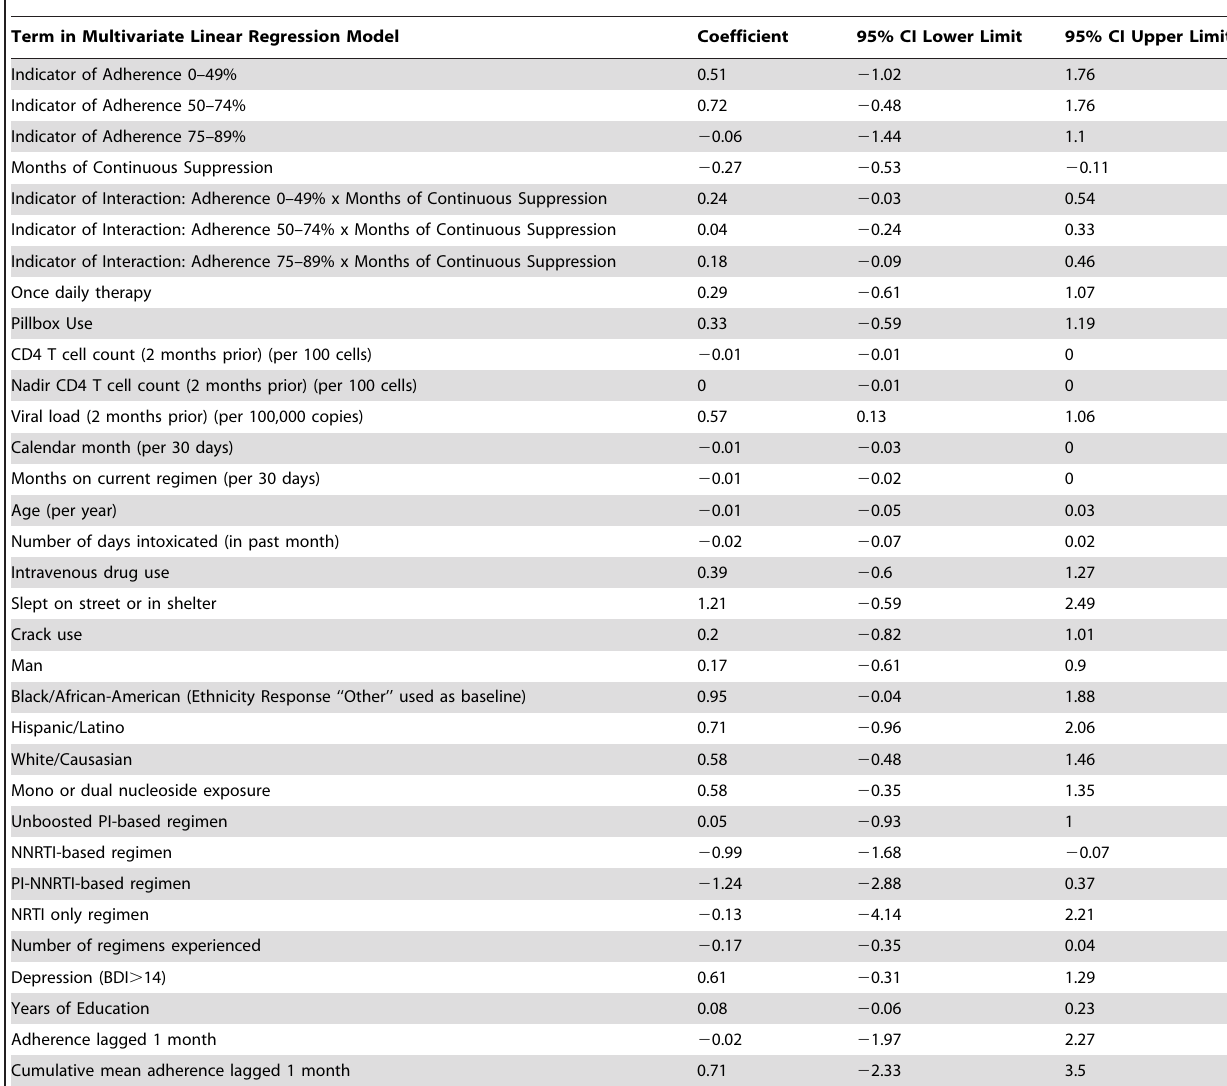
Table 3. Multivariate Regression of Virologic Failure on Adherence, Duration of Continuous Suppression, and Confounders.